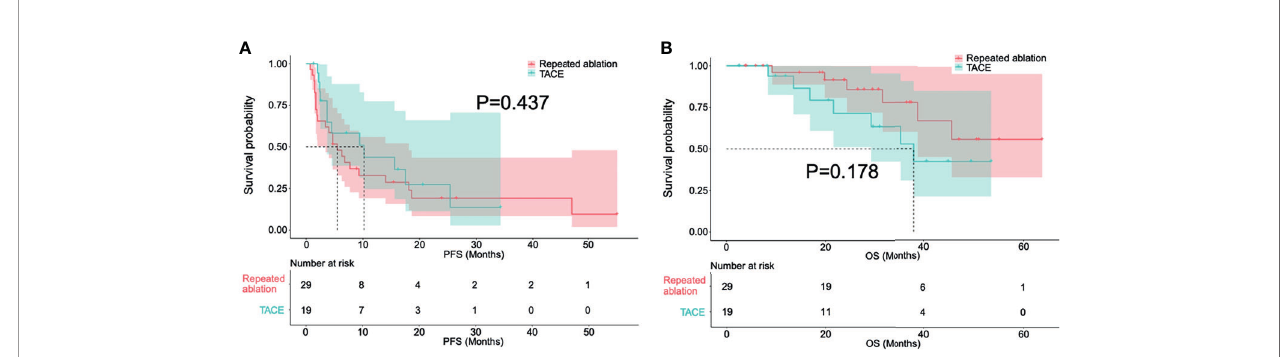
FIGURE 5 | Survival curves in progress-free survival (A) and overall survival (B) of patients treated with repeated ablation and transarterial chemoembolization after a fi rst attempt incomplete ablation.